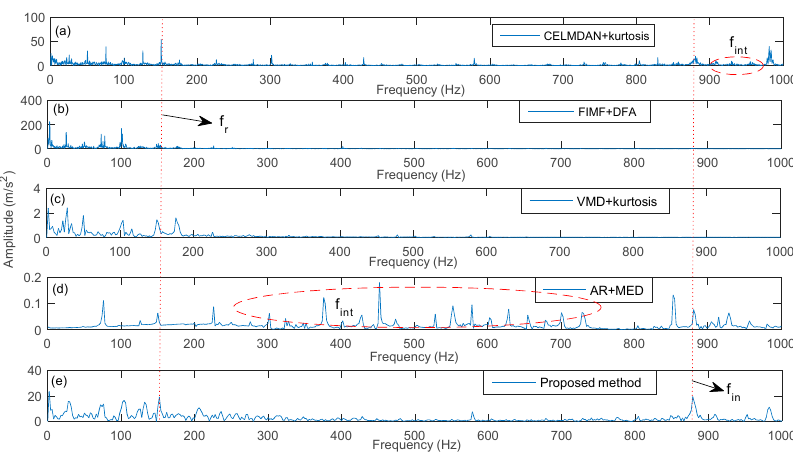
Figure 32. Identified fault frequency of a rolling bearing at 7500 RPM.